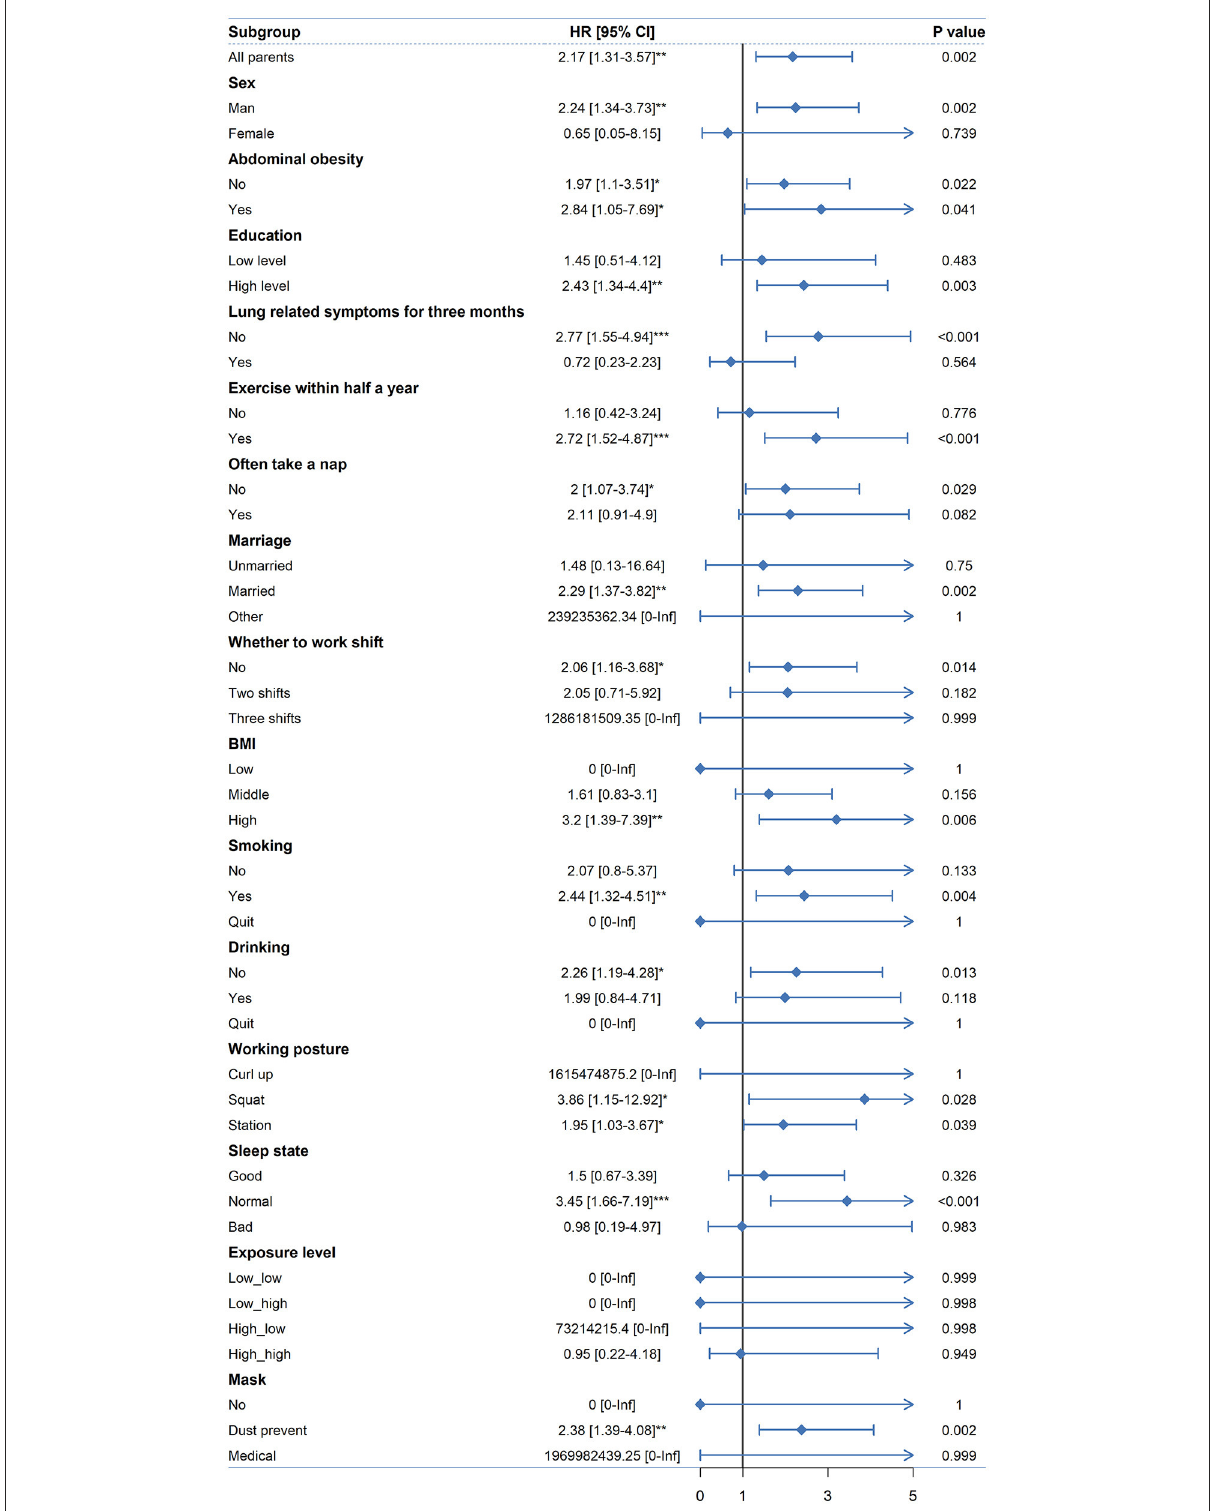
FIGURE1 Cox model subgroup analysis of lung-related diseases and exposure to welding fumes among welders and non-welders. (* p < 0.05; ** p < 0.01; *** p < 0.001).